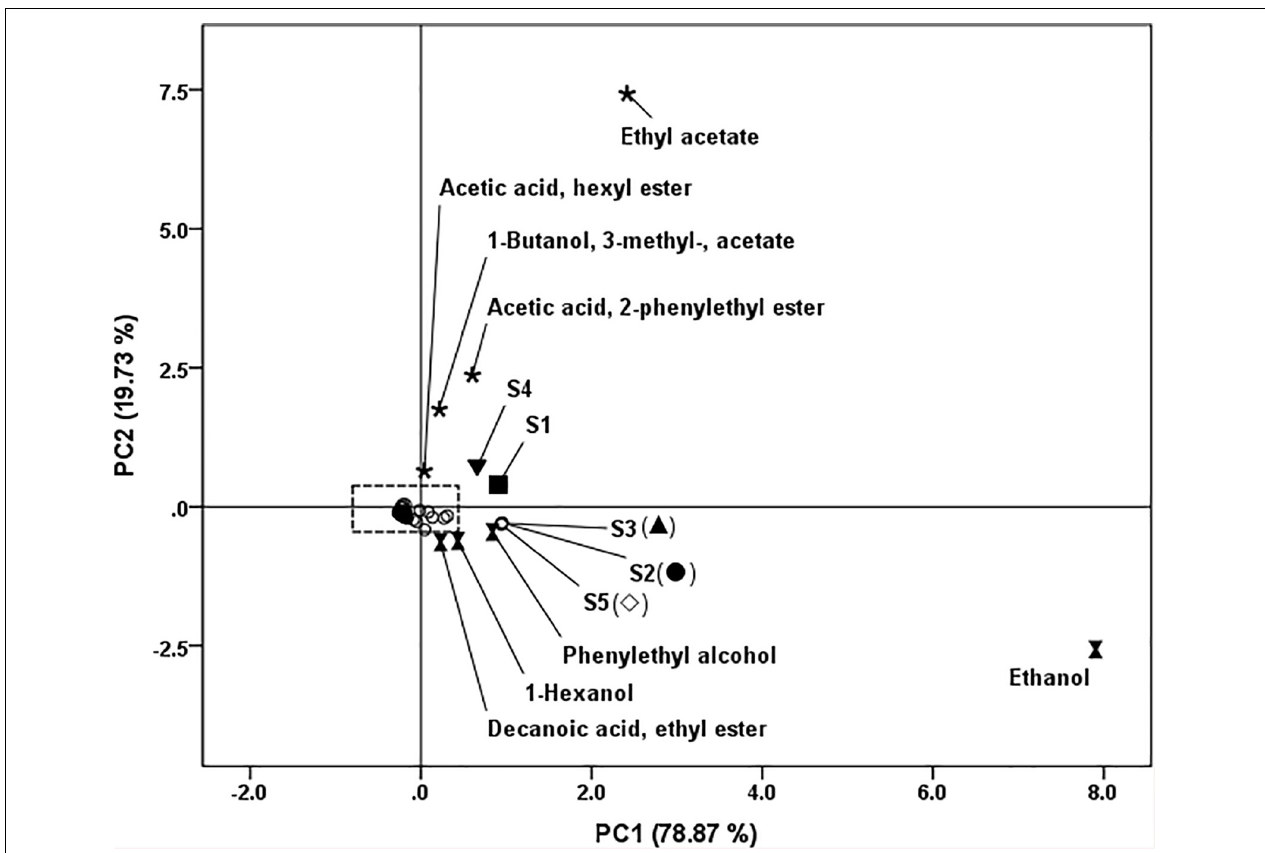
FIGURE 4 | Loadings and scores of principal component analysis of fish sauce fermented with different yeasts. S1 ( (cid:4) ): inoculated with Kluyveromyces marxianus NCYC1425; S2 ( . ): inoculated with Torulaspora delbrueckii Biodiva; S3 ( (cid:78) ): inoculated with Saccharomyces cerevisiae Lalvin EC-1118; S4 ( (cid:72) ): inoculated with Pichia kluyveri Frootzen; S5 ( ♦ ): inoculated with Candida versatilis NCYC1433.